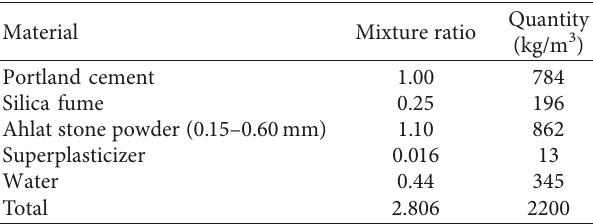
Table 12: The mixture ratio and amounts for the production of ASWC and ASCC.